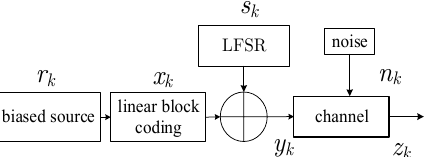
Figure 2. Signal model studied in the present paper.